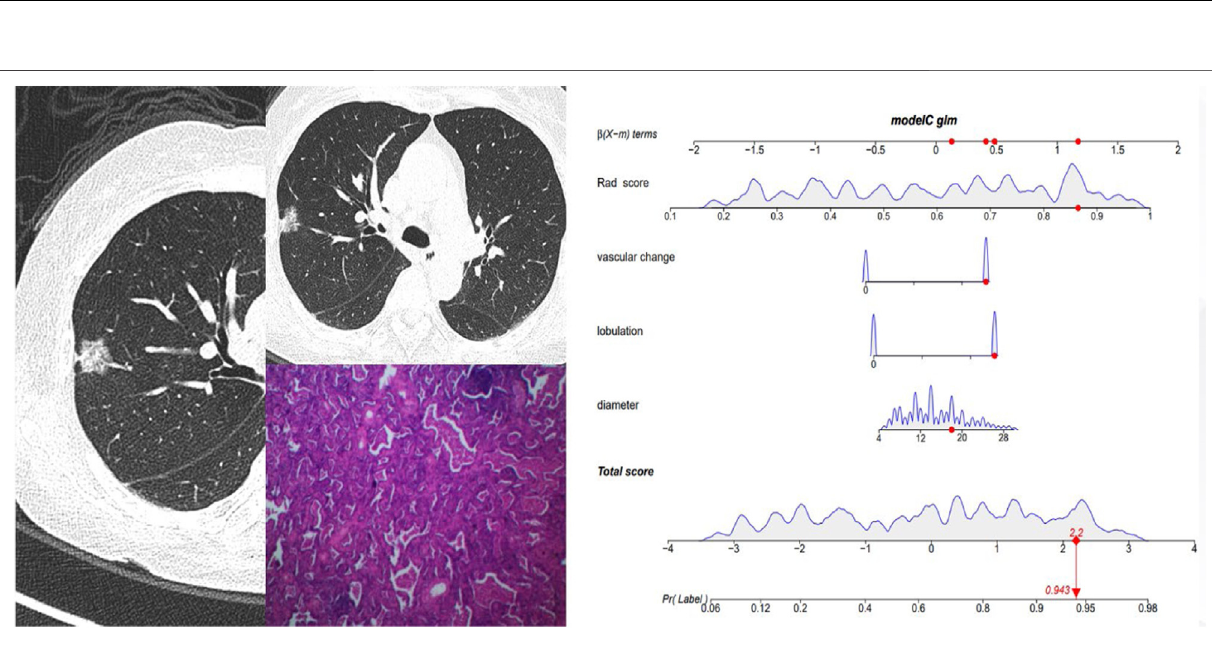
FIGURE 6 | Female, 62 years old. CT showed a mGGN of 18 mm in the right upper lobe, with signi fi cant lobulation and vascular change, and the Rad score of pGGN was 0.864. The interactive nomogram showing the IAC risk probability of this nodule was 0.943. The case was con fi rmed as